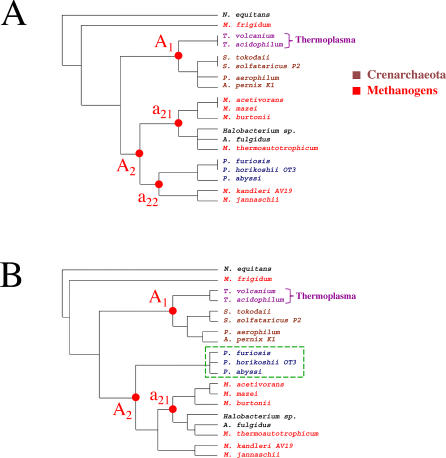
Archaeal BranchThe archaeal branch is represented in more detail with (A) archaea subtree (see Materials and Methods), based on the restriction of the Jaccard scores matrix to the lines corresponding to archaeal species, and (B) archaea only subtree based on the restriction of the Jaccard scores matrix to the lines and the columns corresponding to archaeal species.